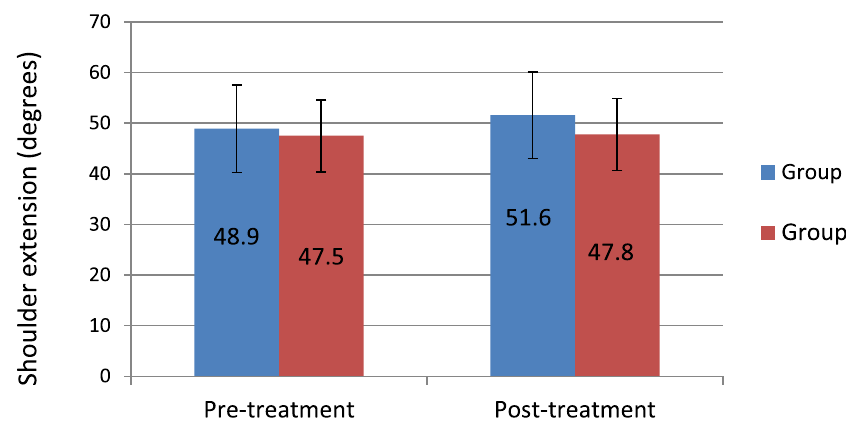
Fig. 10 Mean values of shoulder extension pre- and post-treatment between both groups